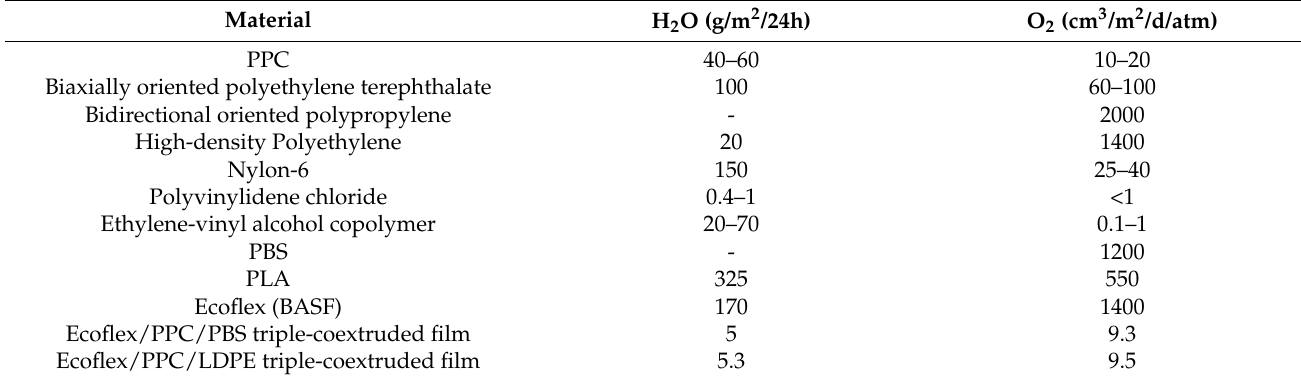
Table 5. Barrier properties of different polymers